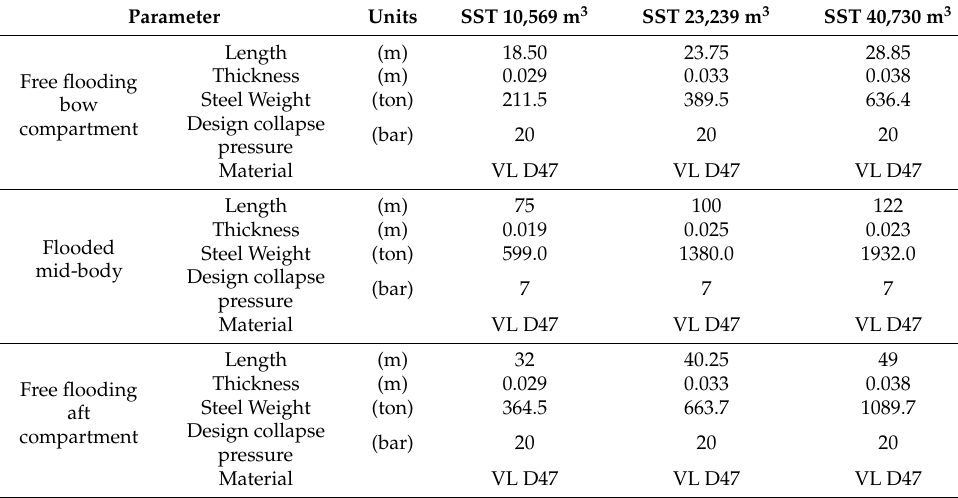
Table 4. Baseline design SST external hull